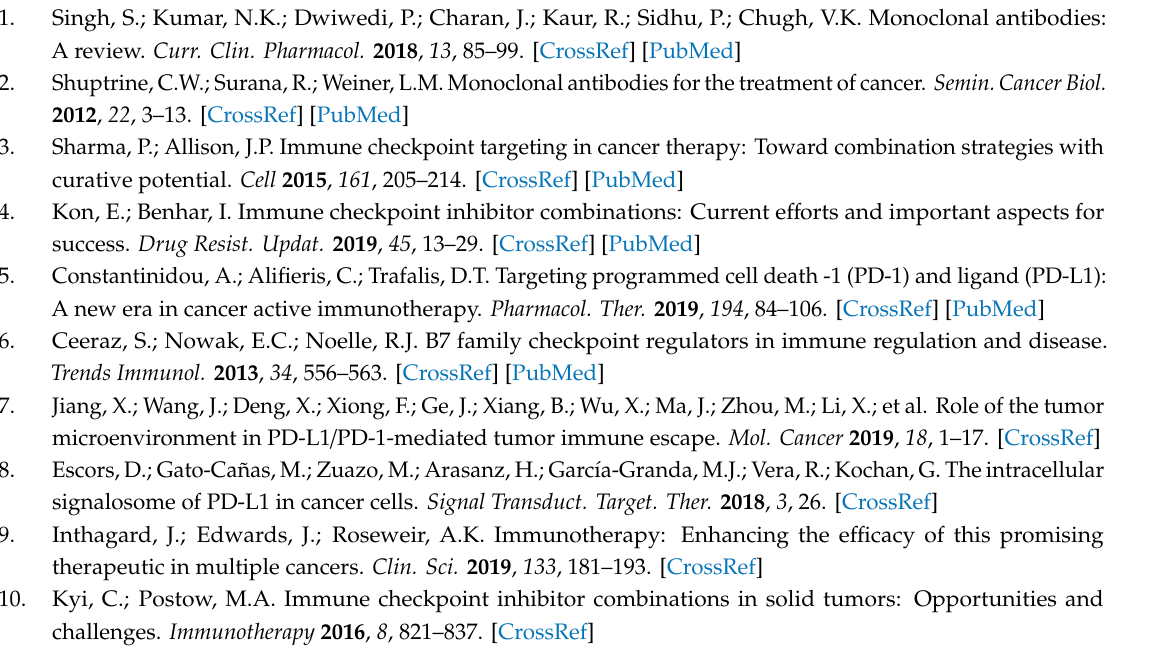
Figure S1: Antitumor e ff ect of a-PD-1 and